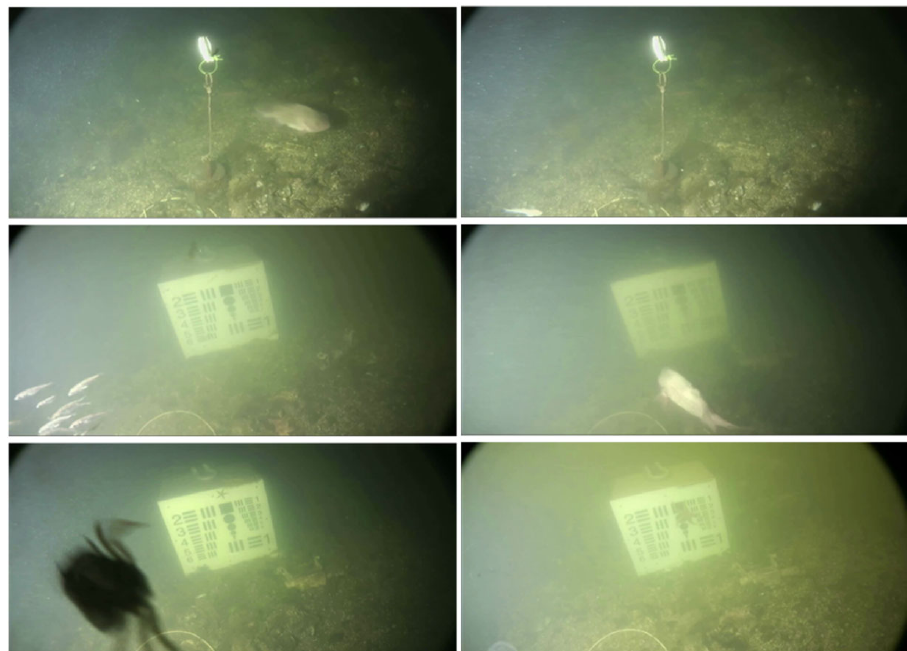
Figure 10. Example images of the Brackish dataset.